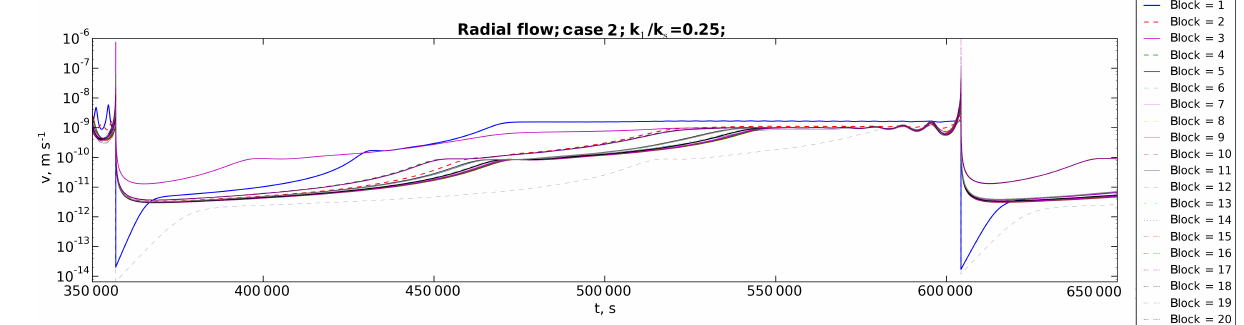
Figure 26. Block velocity variations in time for the system consisting of 20 blocks in Case 2.